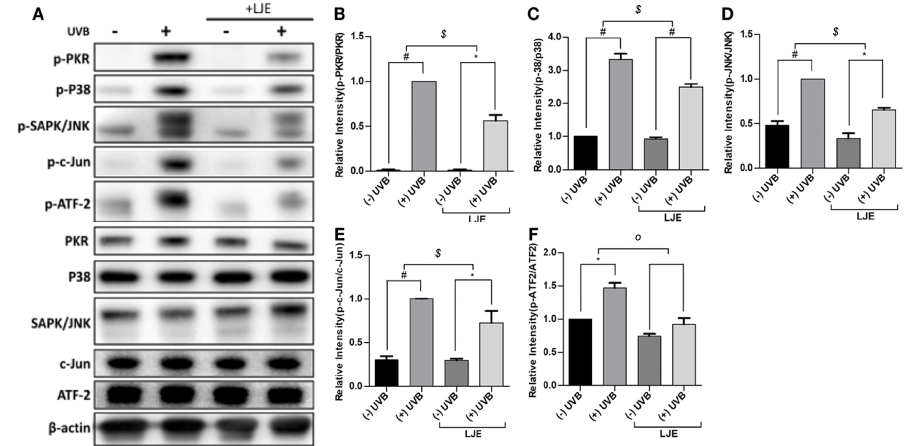
Figure 4. Effect of LJE on UVB-mediated MAPK signaling in keratinocytes. Keratinocytes were treated with LJE (100 µg/mL) for 48 h prior to UVB irradiation (5 mJ/cm 2 ). Six hours after irradiation, the PKR phosphorylation and MAPK activation were analyzed with ( A ) Western blots, ( B–F ) the quantitative results are shown. *p < 0.05, #p < 0.01 , compared to basal levels; o p < 0.05 , $ p < 0.01, compared between (−) LJE and (+) LJE groups.